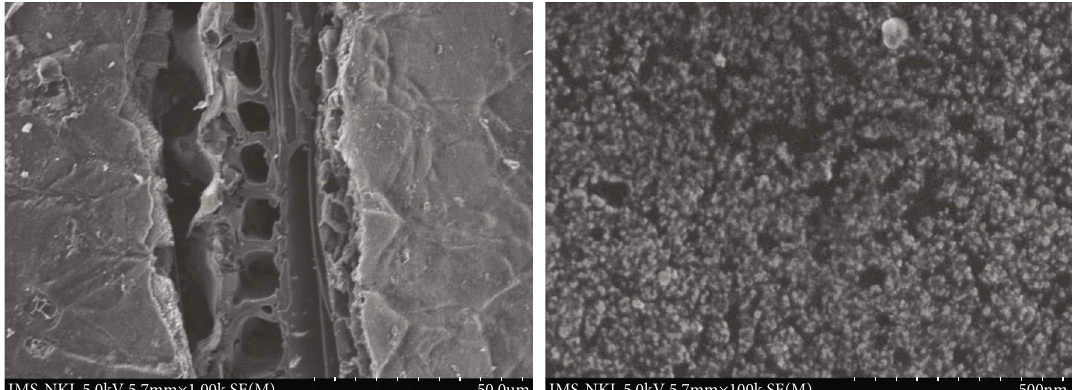
Figure 8: SEM images of BC2.